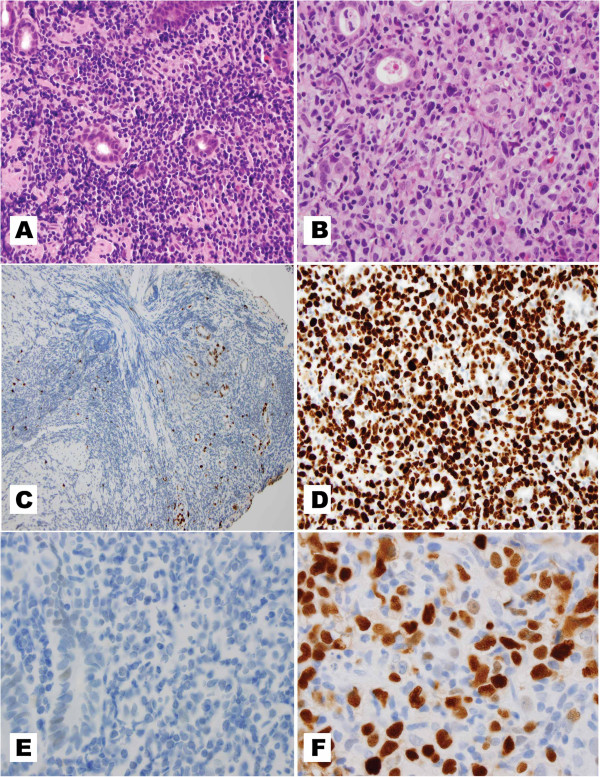
A,C, and E depict a low grade gastric marginal zone lymphoma of mucosal associated lymphoid tissue (MALT). B, D, and F depict a gastric diffuse large B cell lymphoma (DLBCL). (A) MALT in a gastric biopsy (H&E, 400X). (B) DLBCL in a gastric biopsy (H&E, 600X). (C) Ki-67 shows a low proliferative index in a low grade MALT (Ki-67 immunohistochemistry, 200X). (D) Ki-67 shows a high proliferative index, 100%, in this DLBCL. The negatively stained cells are the glandular epithelial cells. (Ki-67 immunohistochemistry, 400X). (E) P53 protein is absent in the tumor cells of a MALT, while weak nuclear P53 staining is seen in the adjacent benign glandular epithelium (P53 immunohistochemistry, 1000X). (F) P53 protein overexpression is noted in the tumor cells of this DBLCL, while the cells negative for nuclear P53 immunostaining are benign glandular epithelial cells. (P53 immunohistochemistry, 1000X).